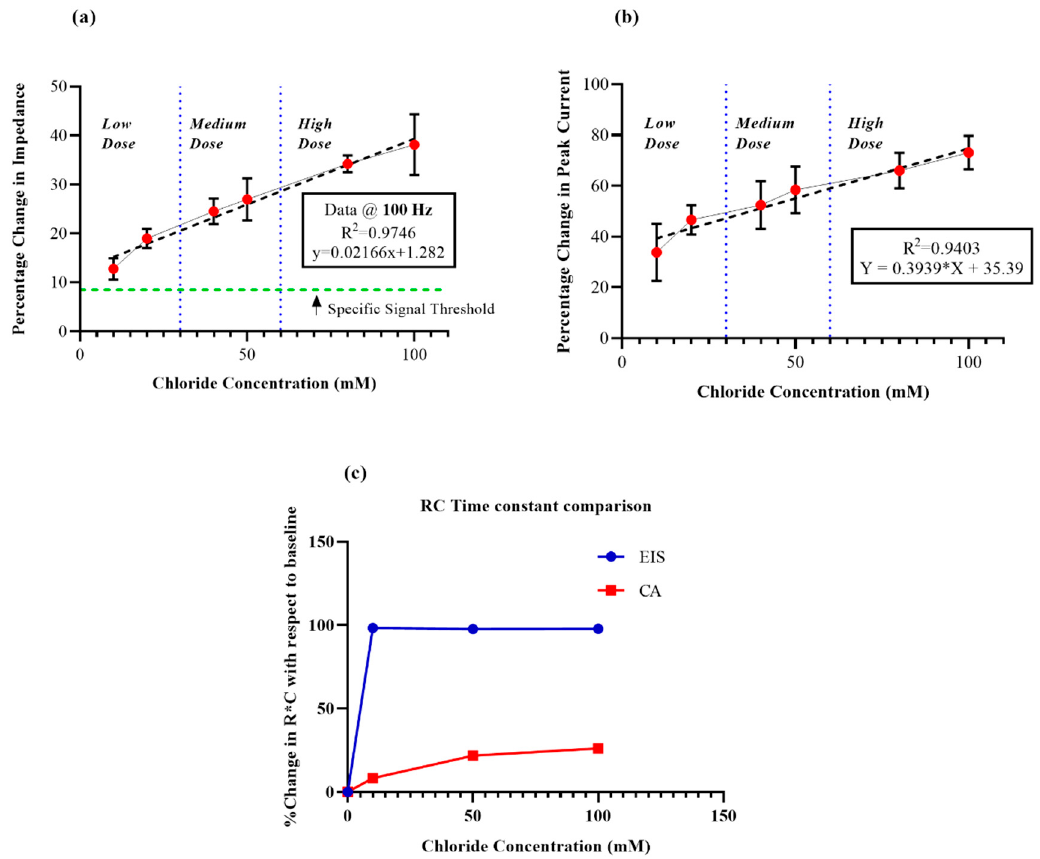
Figure 5. ( a ) Calibration dose response for non-faradaic EIS (100 HZ) for low, medium, and high chloride doses (n = 5), ( b ) Calibration dose response for non-faradaic chronoamperometry (CA) for low, medium, and high chloride doses (n = 4), ( c ) Comparison between the time constant (product of R ct and C dl ) of the EIS data and the average discharging time constant of the chronoamperograms.